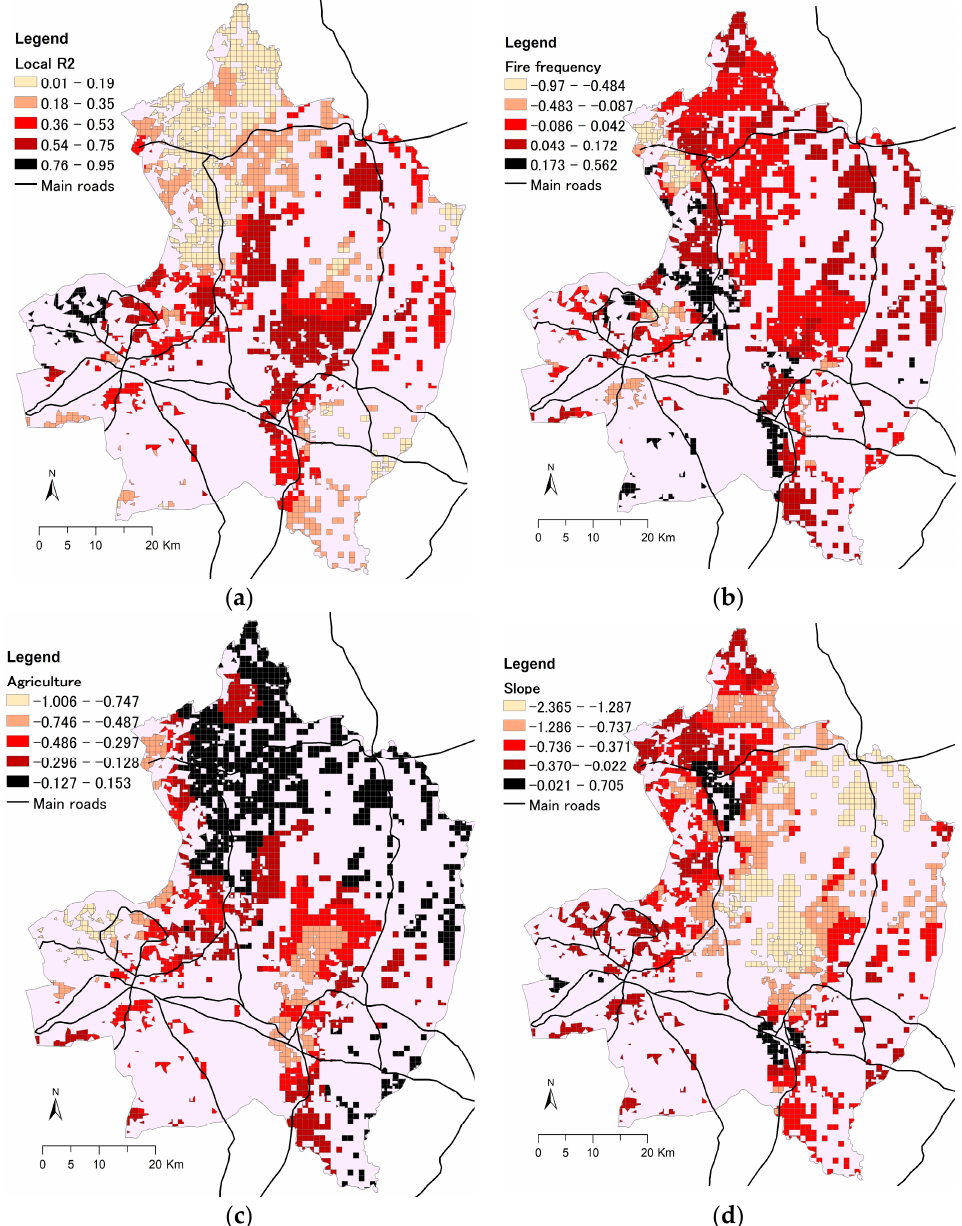
Figure 5. Spatial mapping of the locally weighted coefficient of determination ( R 2 ): ( a ), fire frequency ( b ), agriculture ( c ), slope ( d ), GWR modeling for dense miombo. The more intense the brown color, the stronger the correlation. The cell sizes are 1000 × 1000 m.